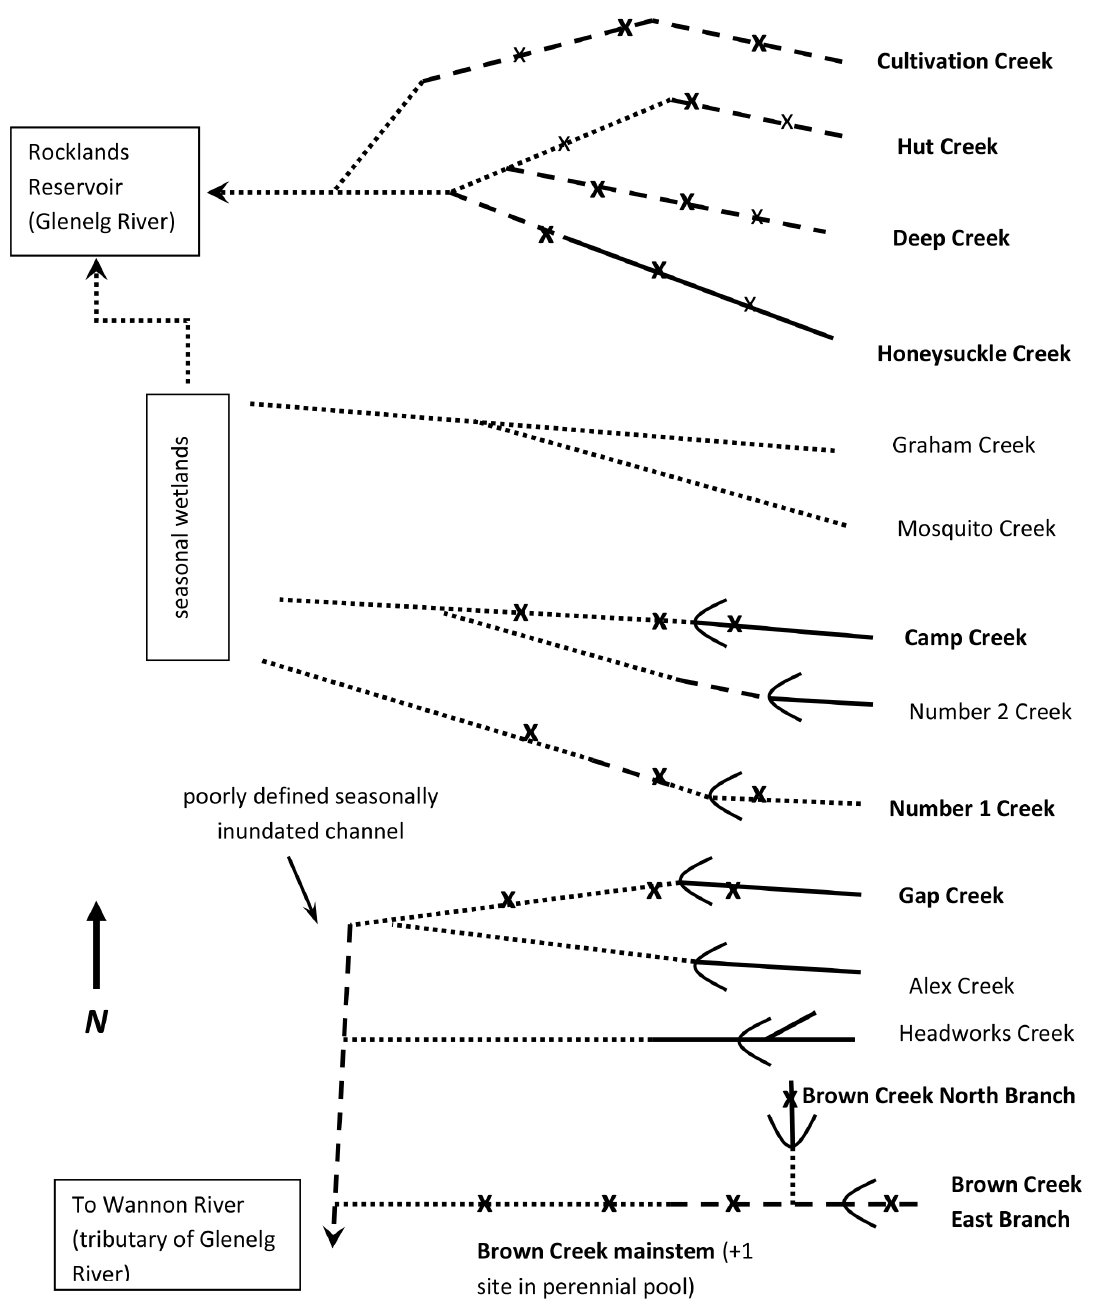
Figure 1. Diagram of the study streams (named in bold) in the Victoria Range, showing flow regimes and representing conditions at peak dryness, without summer passing flows (solid lines = perennial flow, dashed lines = seasonal flow with perennial pools and dotted lines = seasonal, completely dry) and weirs (‘U’ shapes). Survey sites denoted by ‘ x ’: primary sites were upstream and downstream of weirs, and at similar elevations on unregulated streams; all potential fish/crayfish refuges were sampled. Sites with faint ‘x’ were in surveys prior to this study, and were visited in summer 2008; they were subsequently dropped as they were not needed to characterize the unregulated streams for comparison with the regulated ones. General flow direction is from right to left. Note that this is a schematic diagram and is not to scale.